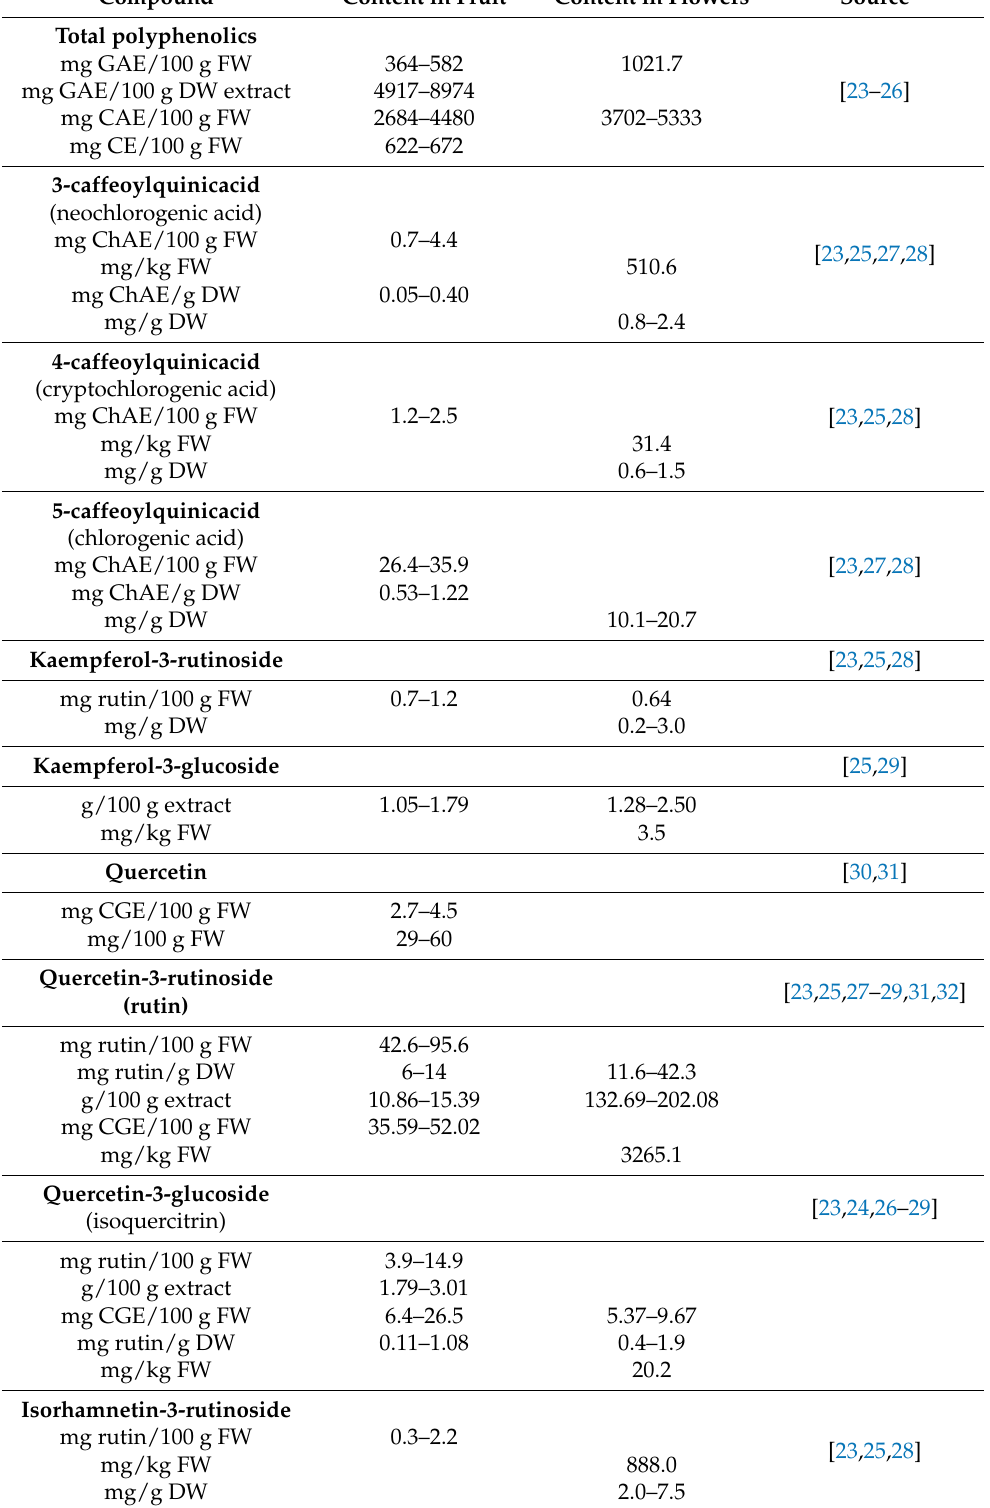
Table 3. The content of phenolic compounds in elder fruits and